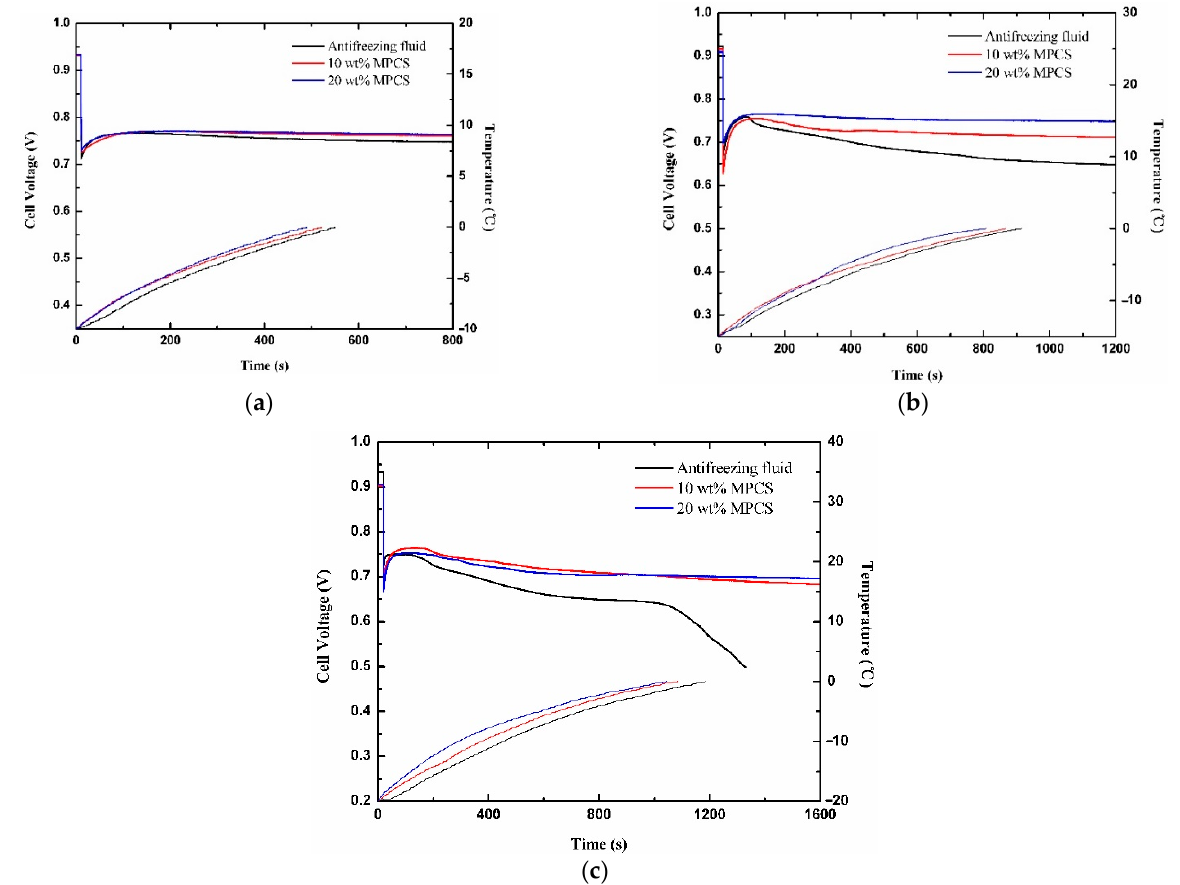
Figure 13. The cell voltages and temperatures at different mass concentrations of antifreeze fluid ( a ) − 10 °C ( b ) − 15 °C ( c ) − 20 °C.